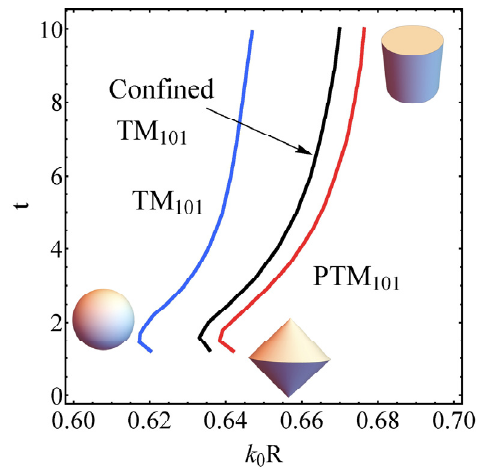
Figure 12. Perfect nonradiating PTM modes of superspheroids with ε = 50 as a function of the size parameter, k 0 R , and the shape parameter, t . The red curve stands for PTM 101 perfect nonradiating mode (PTM) and the blue line corresponds to the usual TM 101 mode. The black curve corresponds to the confined ( ε → ∞ ) TM 101 mode (18).